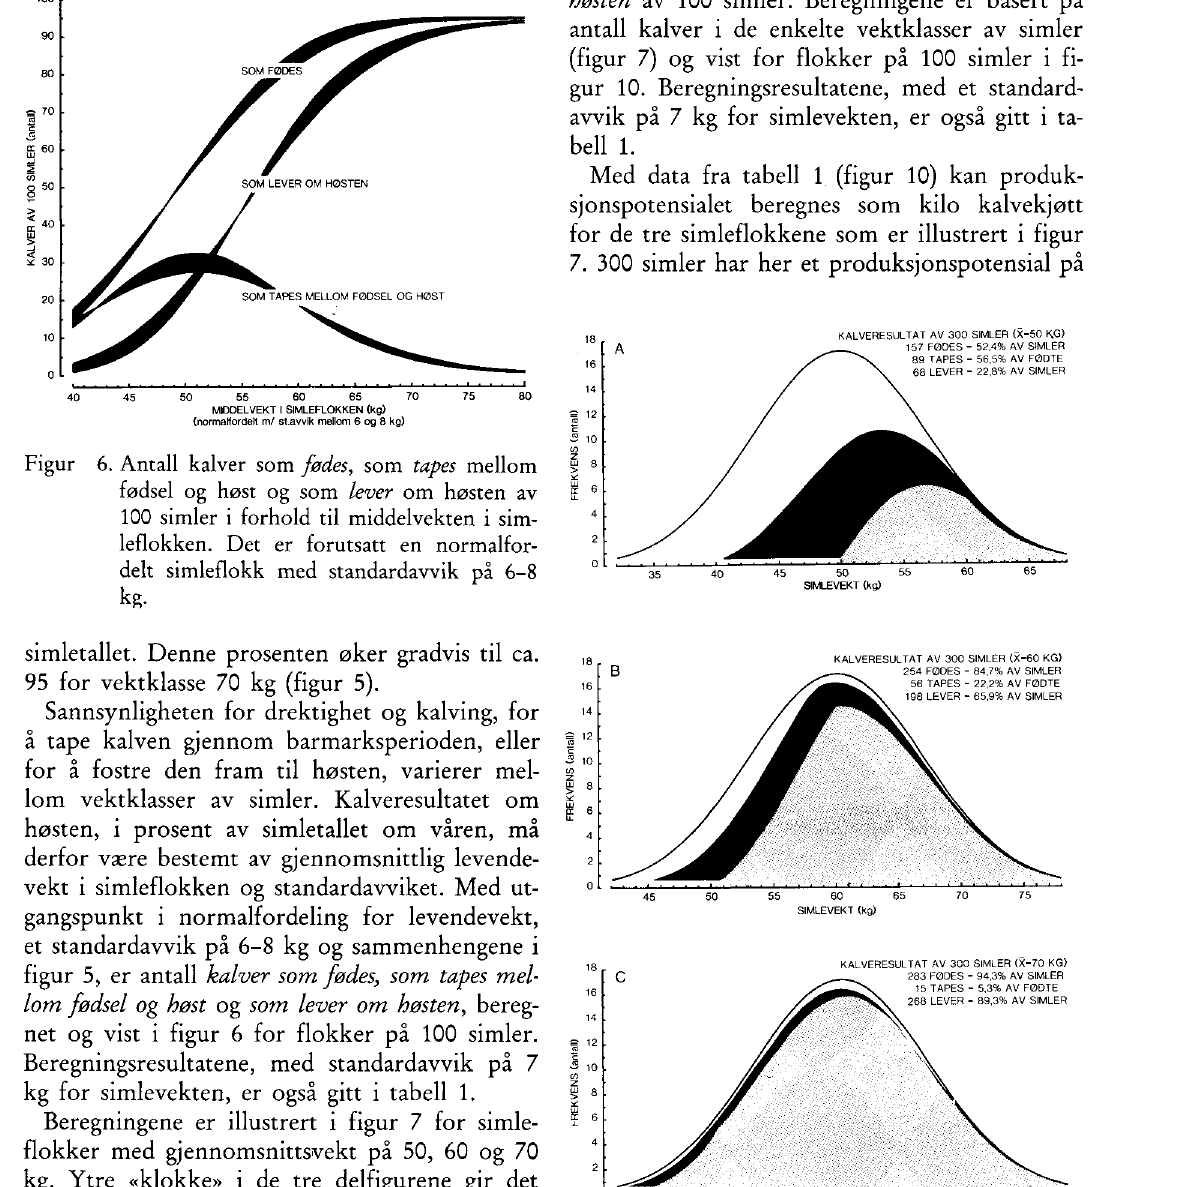
Figur 7. Illustrasjon av tre simleflokker med gjenn omsnittsvekt på 50, 60 og 70 kg. Ytre «klokke» i delfigurene gir det normalfordel¬ te antall av 300 simler i vektklasser på hele kilo med standardavvik på 7 kg. Svart og grå del i «klokkene» angir sammen antall av kalver som fødes. Svart del viser kalver som tapes mellom fødsel og høst, mens grå ten. Beregningene er en utdyping av